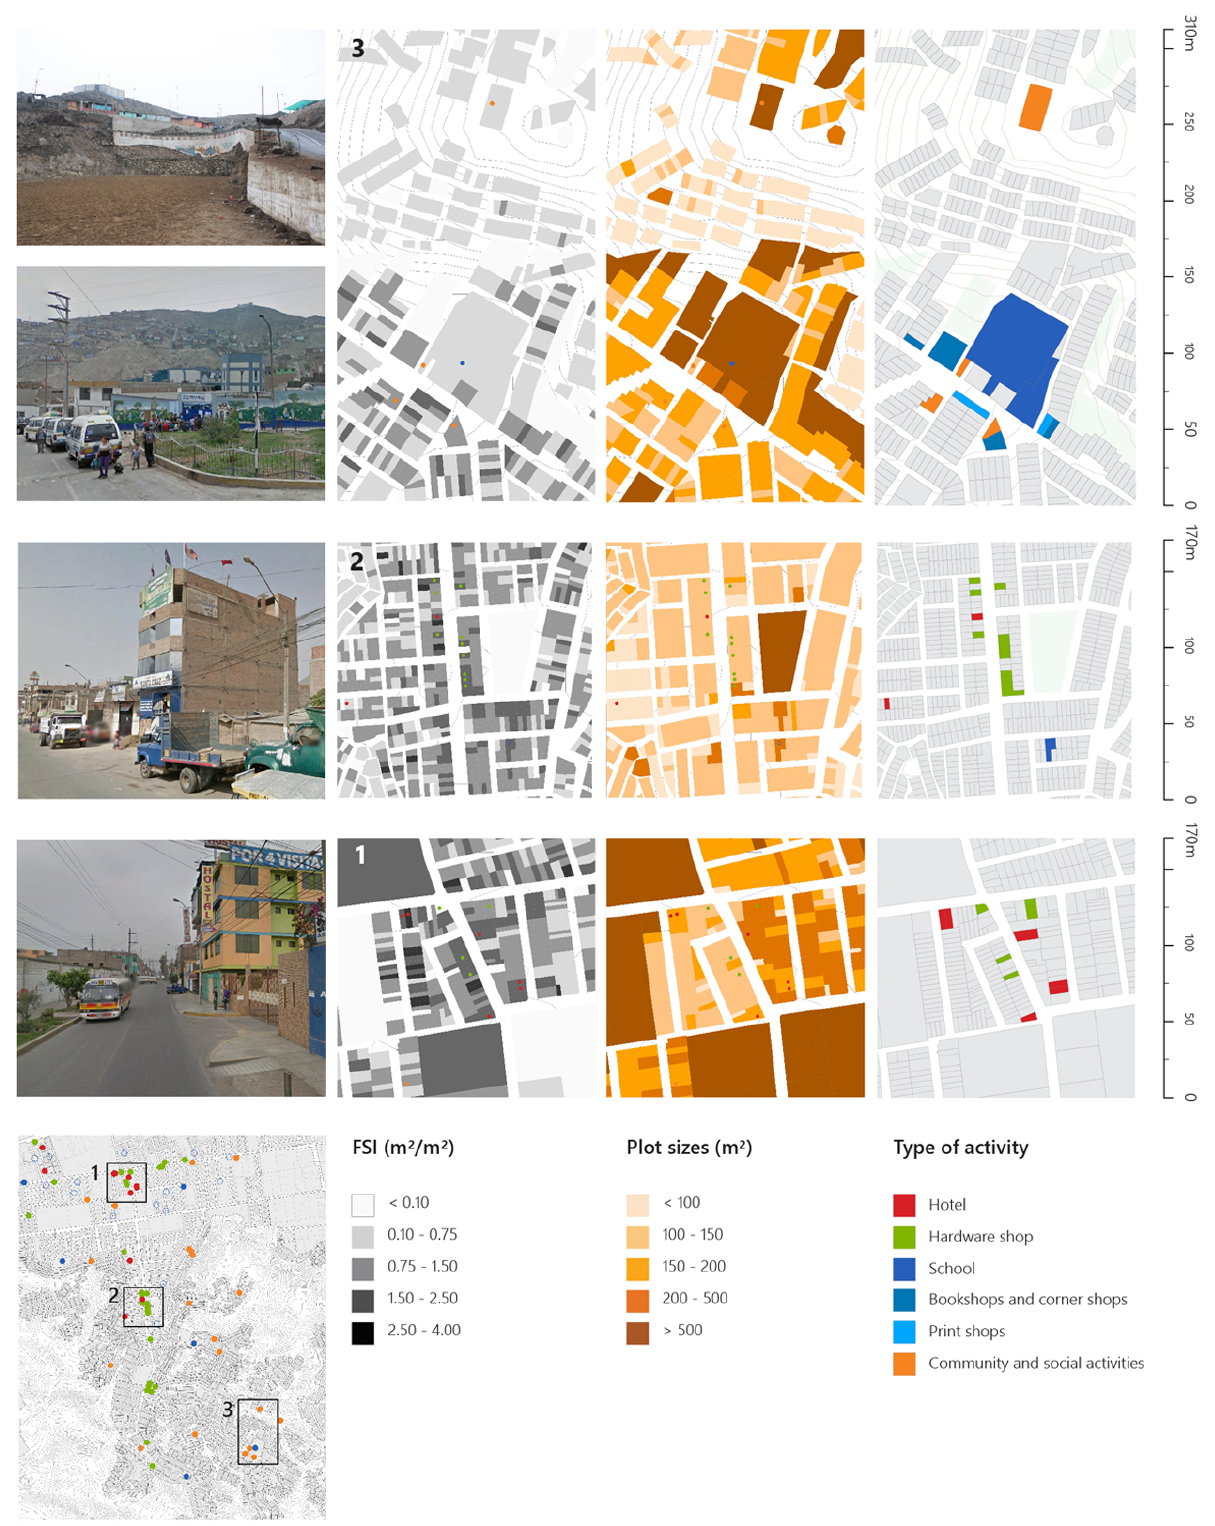
Figure 8. Spatial characteristics for different types of activities in Valle Amauta. Source: Analysis and mapping by the au- thors with data from INEI (2019), Ministry of Education of Peru (2019), Municipality of Ate (2016), Municipality of Lima (2013b). Pictures from Google Street View (in 2013) and by the